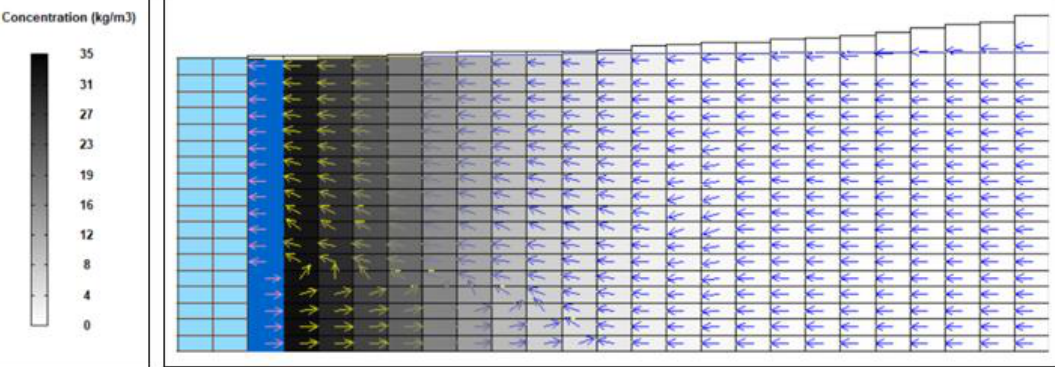
Figure A8. Location of the seawater intrusion in the area of Ambabbo locality in 2100 under scenario RCP 4.5. NS vertical section. Concentration in kg/m 3 .